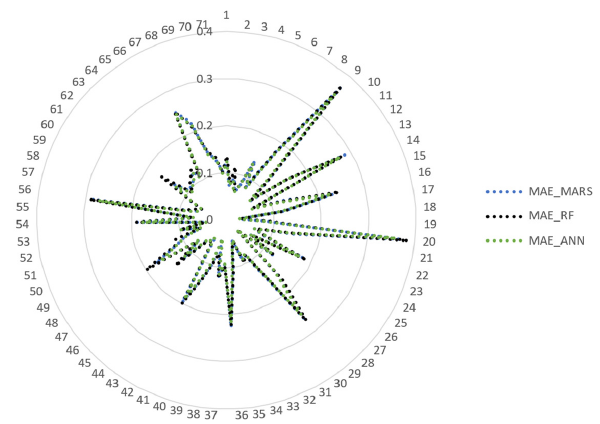
Figure 4. Radar chart involving MAE (in kWh) for different Consumer IDs.